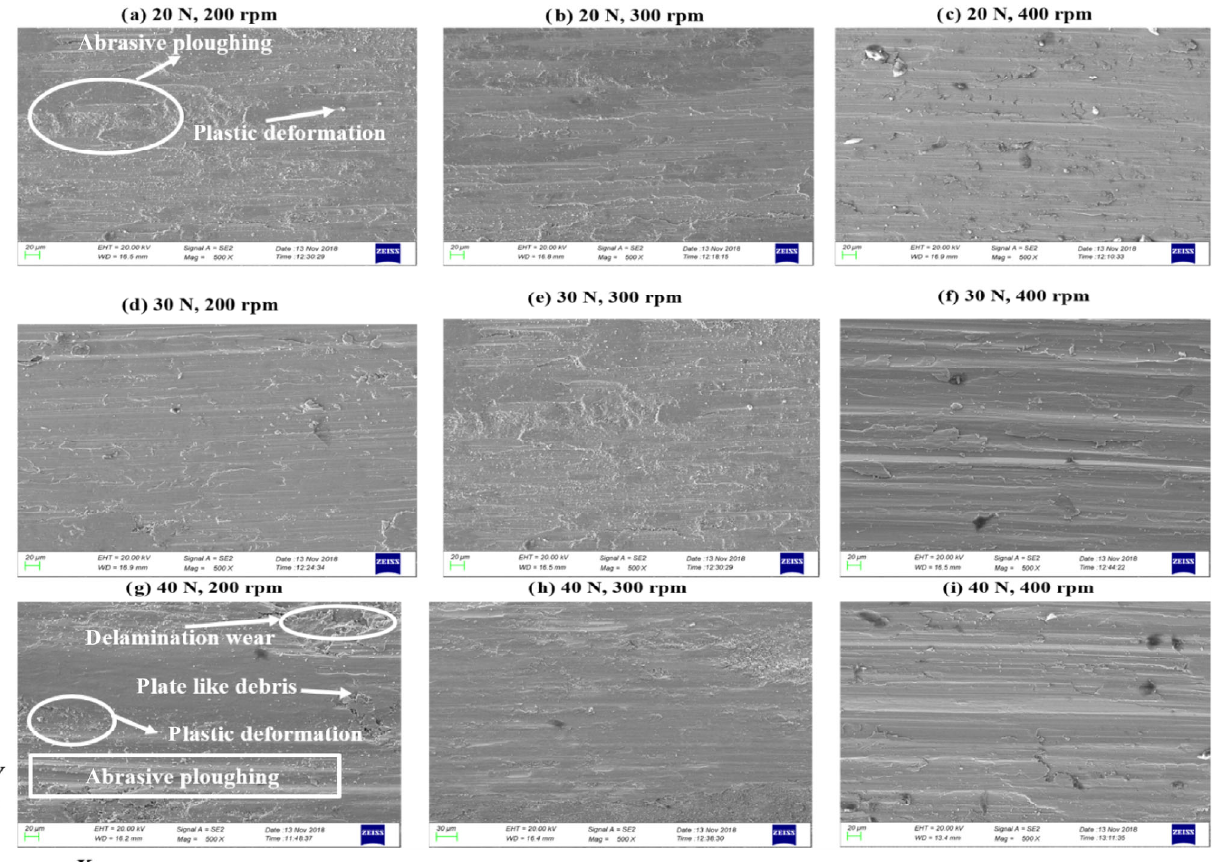
Fig. 24 SEM micrographs of AISI 304 steel for different normal loads under the speed = 200, 300, and 400 rpm. (a–c) 20 N, (d–f) 30 N, and (g–i) 40 N ( x represents the sliding